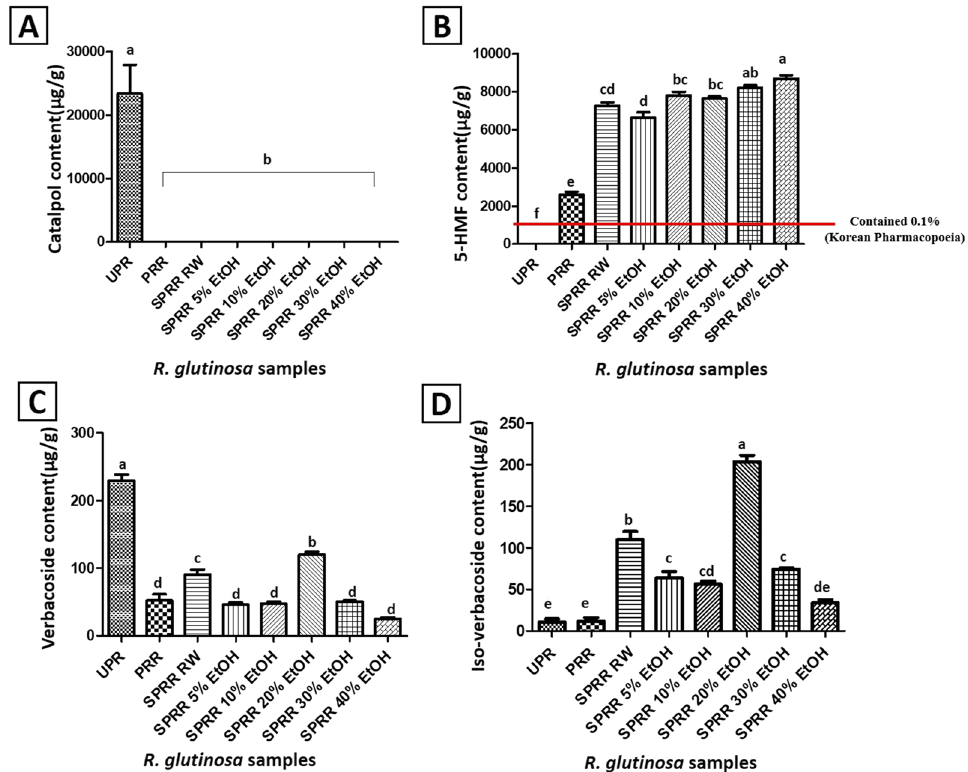
Fig. 5 Effect of different additive supplements (rice wine, 5% EtOH, 10% EtOH, 20% EtOH, 30% EtOH, and 40% EtOH) on marker compounds content of R. glutinosa samples. a Catalpol content of R. glutinosa samples. b 5-HMF content of R. glutinosa samples. c Verbacoside content of R. glutinosa samples. d Iso-verbacoside content of R. glutinosa samples. * UPR Unprocessed R. glutinosa , PRR Processed R. glutinosa , SPRR Supplemented Processed R. glutinosa , RW Rice wine. Values are presented as means standard deviation. Same letters are not significantly different by Tukey’s test ± and p 0.05 =